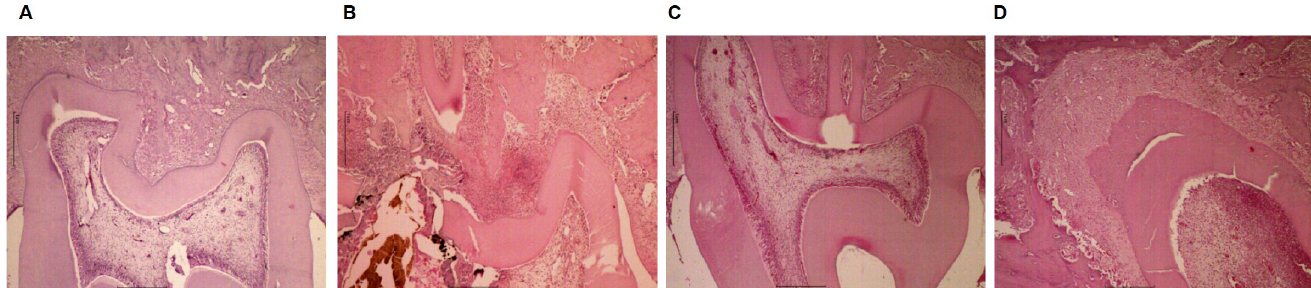
Fig 2. H&E-stained sections of left first molars. Na ï ve (A), open (B), closed (C) or CFA (D) groups, at three days after the surgical dental procedures.